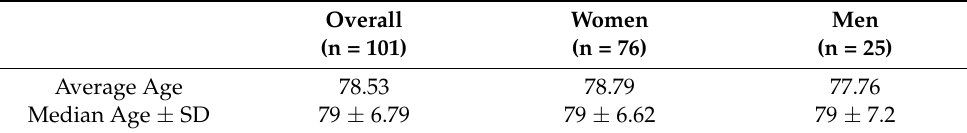
Table 1. Characteristics of study group.